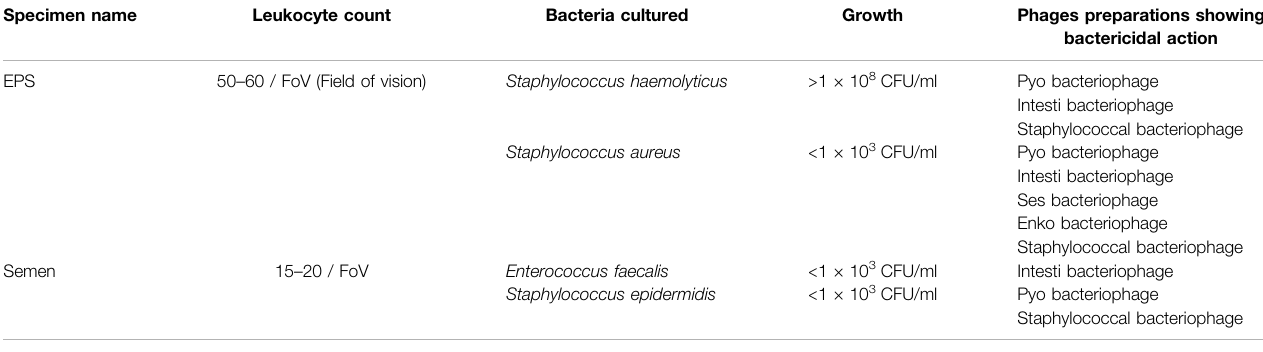
Table 1 | Results of analysis and cultures of fl uids from the infected region — November 2016.